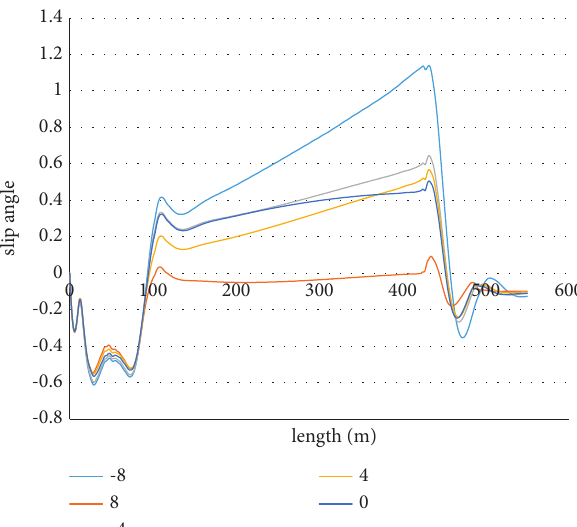
Figure 21: Comparison of slip angle along the path on different slopes.